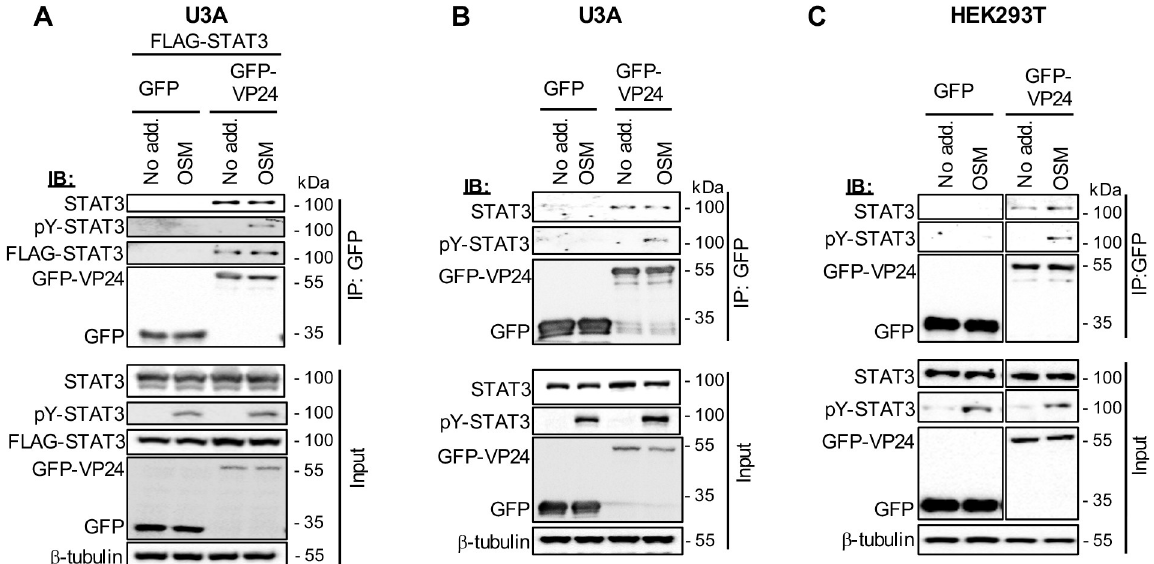
Fig 7. EBOV VP24 interacts with STAT3. (A) U3A cells co-transfected to express FLAG-STAT3 and GFP or GFP-VP24 as indicated were treated 24 h post-transfection with or without OSM (10 ng/ml, 30 min) before lysis, immunoprecipitation for GFP, and IB, as described in the legend to Fig 5. (B, C) U3A (B) or HEK293T (C) transfected to express the indicated proteins were treated with or without OSM (10 ng/ml, 15 min) before immunoprecipitation for GFP and IB for endogenous STAT3. Results are representative of 2 independent assays and show data from a single blot with intervening and marker lanes removed. Expanded images of all membranes are shown in S9 and S10 Figs.